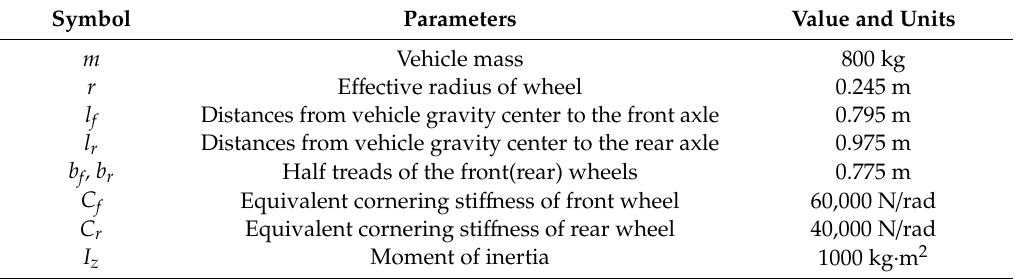
Table 1. Vehicle